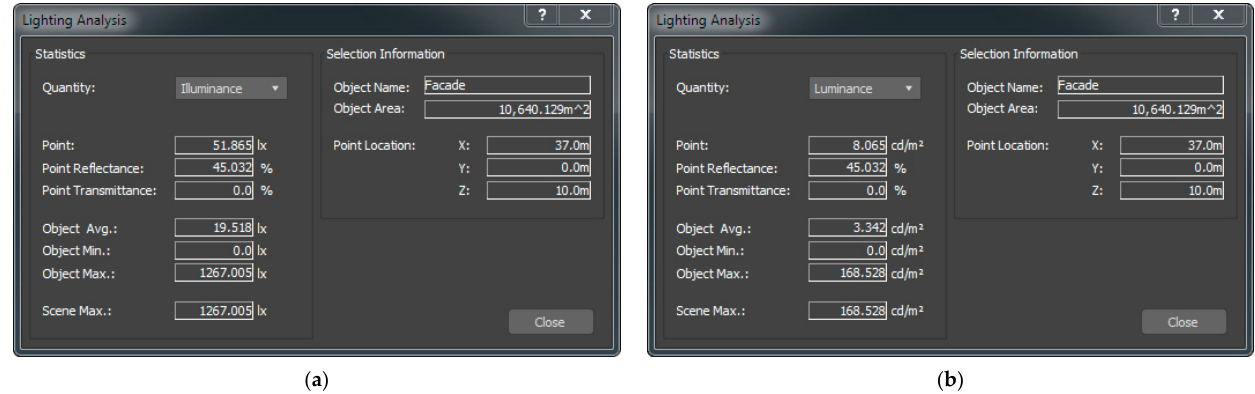
Figure 8. A measuring window for the lighting analysis function for ( a ) illuminance and ( b ) luminance in the floodlighting design carried out by means of the classical 3D model.